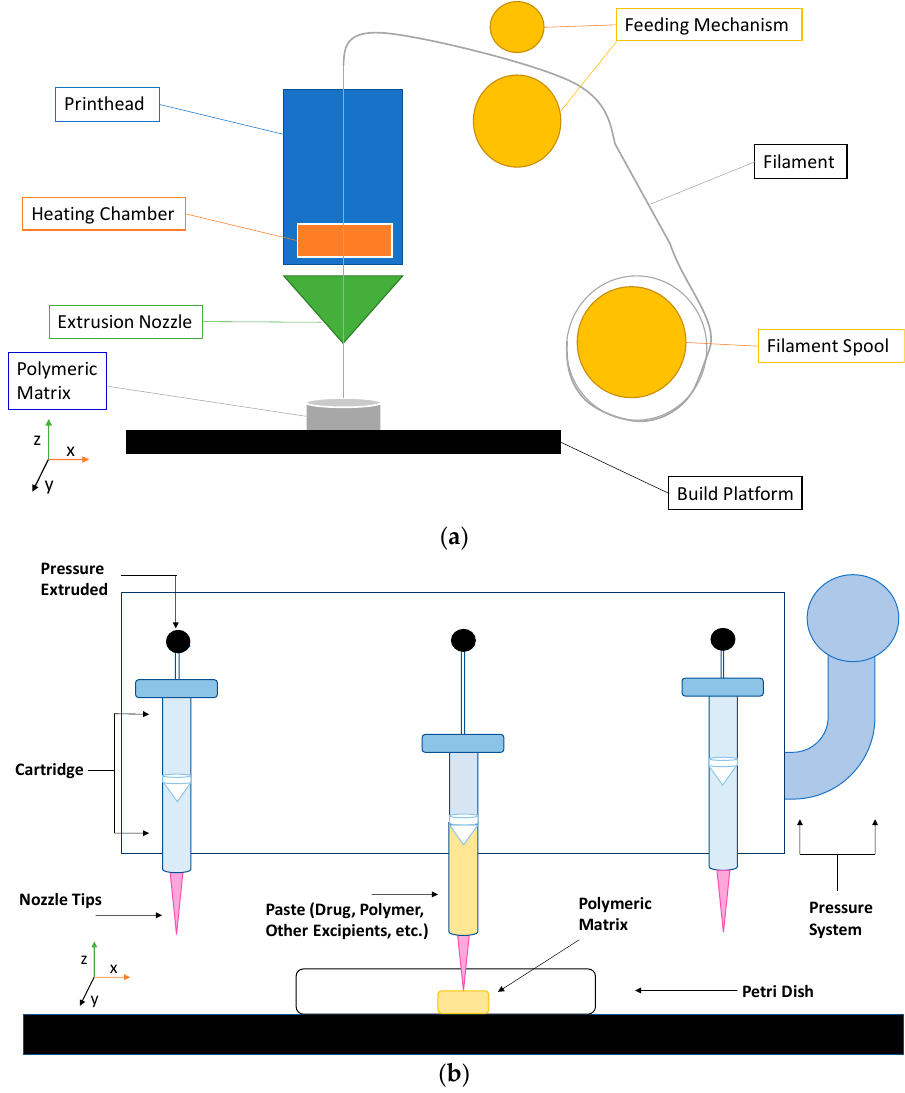
Figure 2. 2-dimensional (2D) schematic of the extrusion-based 3D printing process: ( a ) fused deposition modeling (FDM), ( b ) pressure-assisted microsyringe (PAM).